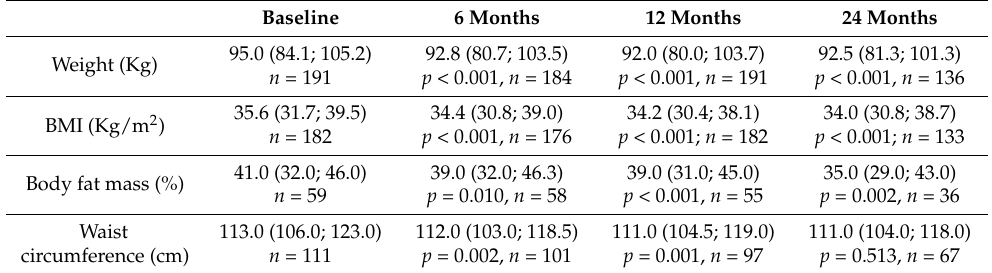
Table 3. Variation in anthropometric characteristics over time (median